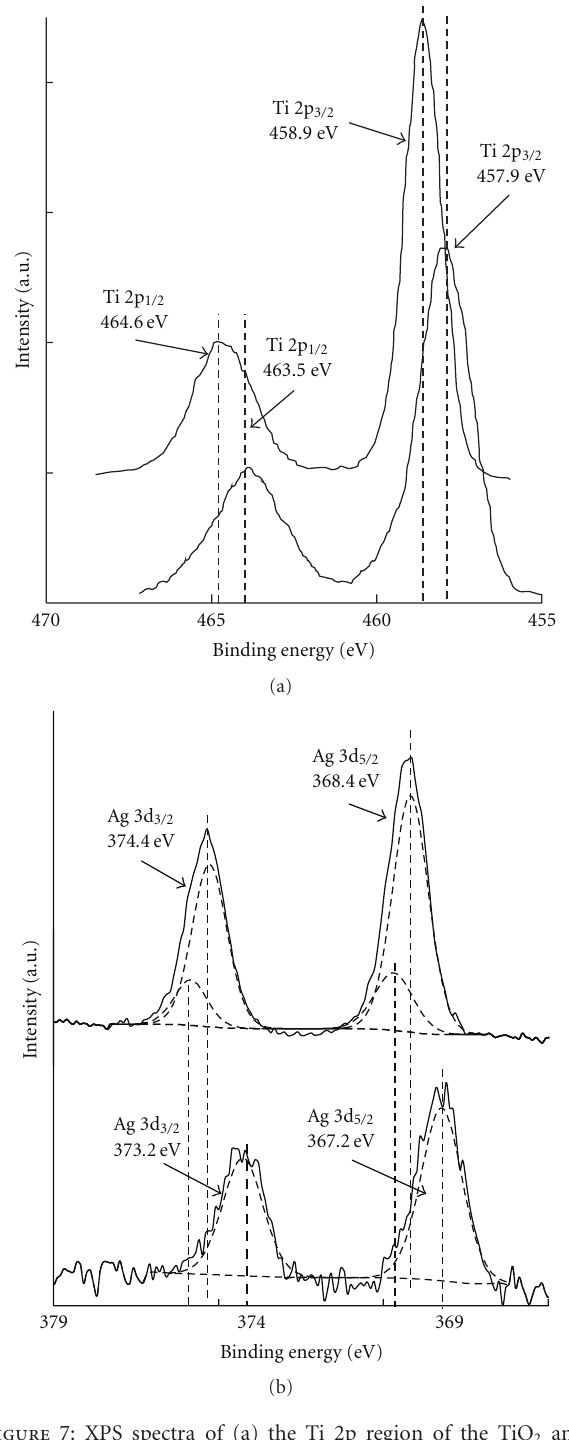
Figure 7: XPS spectra of (a) the Ti 2p region of the TiO 2 and Ag(2)TiO 2 samples and (b) the Ag 3d region of the Ag(2)TiO 2 (top) and solar-simulated light irradiated Ag(2)TiO 2 (bottom)